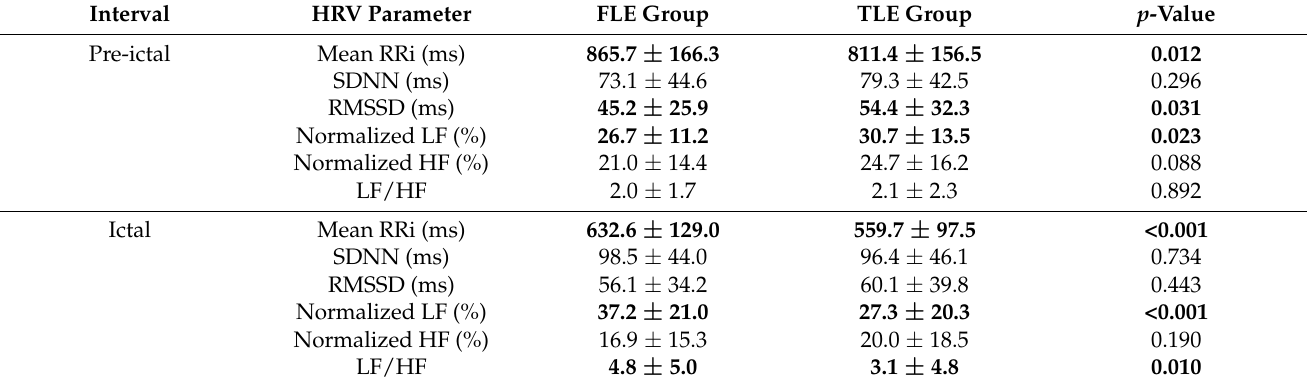
Table 2. Independent t -test of the HRV parameters between FLE and TLE in each interval.